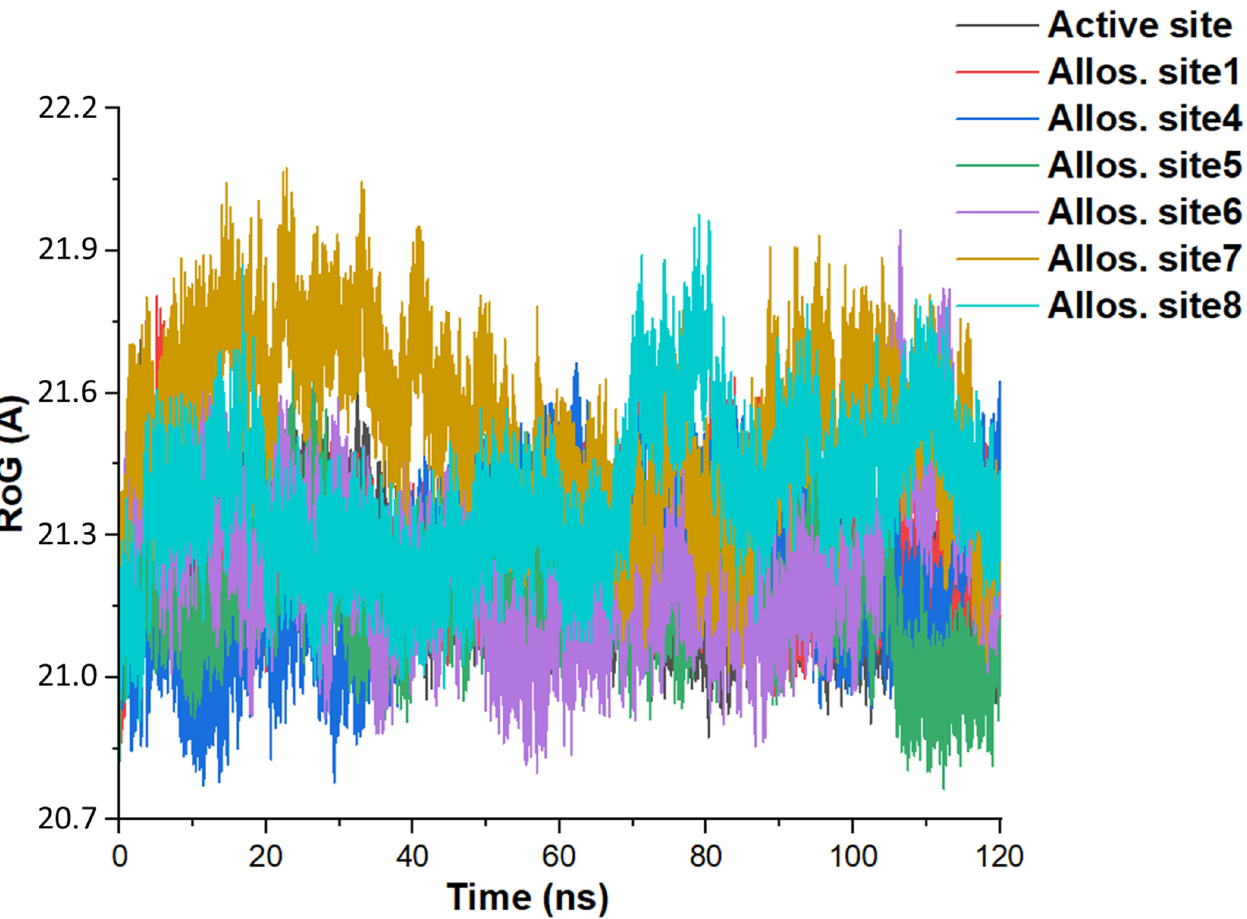
Figure 10. Time (in nanoseconds) evolution of the mass-weighted RoG—radius of gyration (in angstrom) induced by coupling compound 1 to the various regions on BACE1 structure. Allos. site represents the allosteric site and the definition for each site including the interacting residues is available in Figure 6. Table 5. Data analysis of the RoG (in Å) scores over the simulation time (120 ns). Std. represents standard, and Allos. site indicates allosteric site.